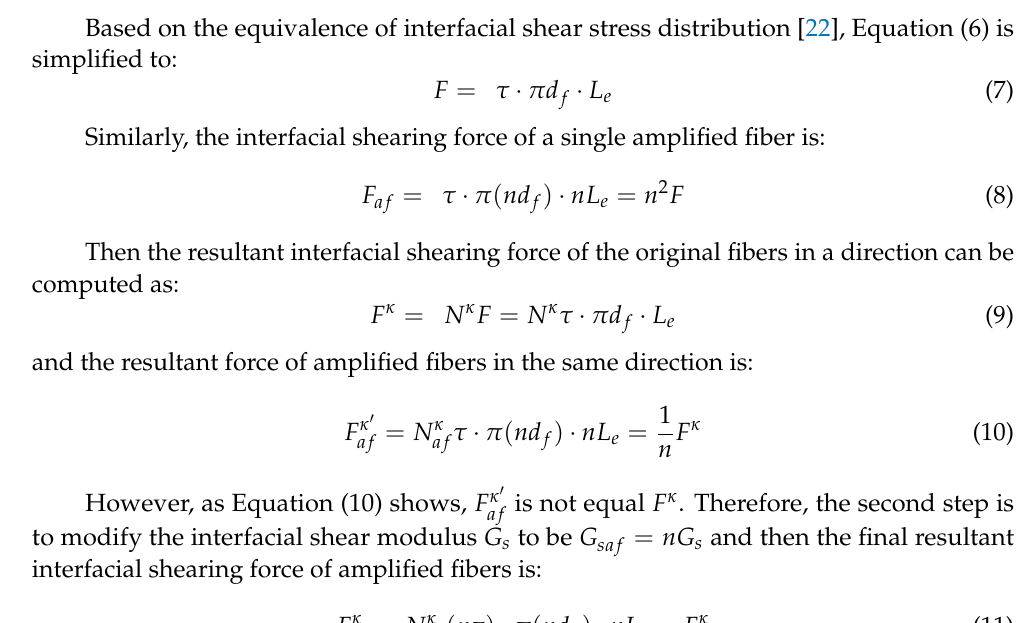
Figure 8. Free-body d iagram of the infinitesimal segment of a fiber .